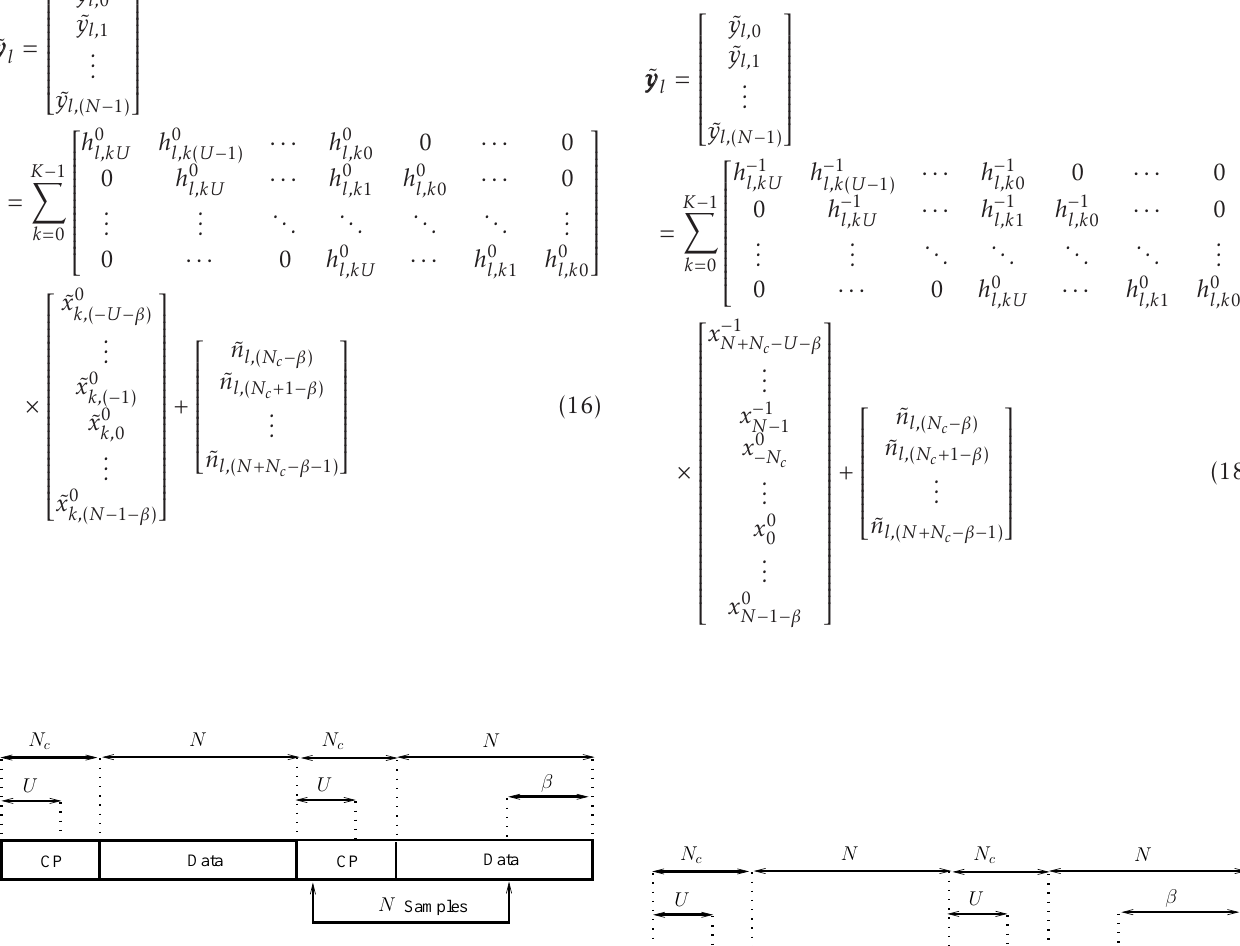
. c − U ≤ β ≤ N c Figure 6. I llustration for the scenario of asynchronous sensing, where N c ≤ β < N